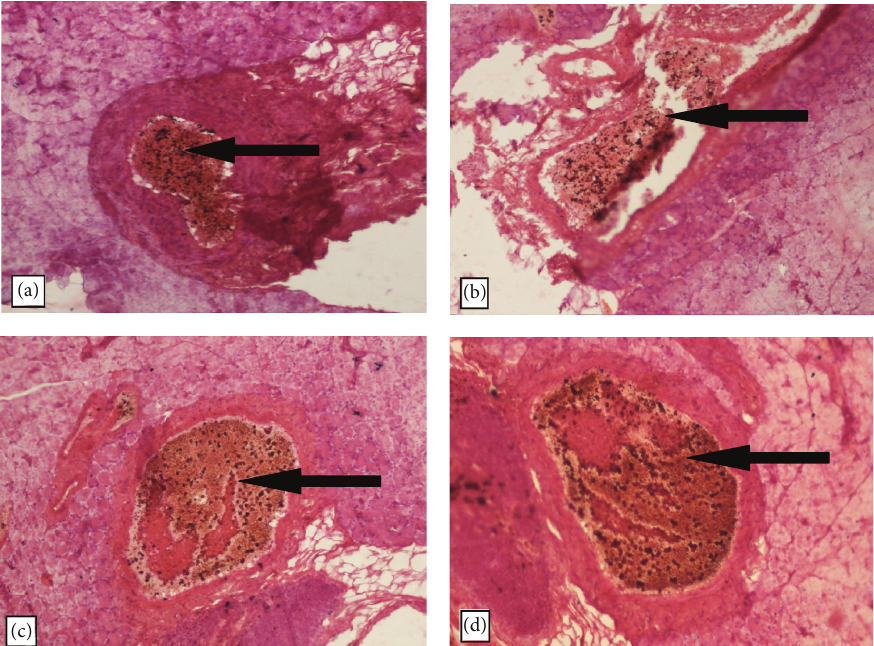
Figure 8: Histopathological view of rat pancreas on treatment with H. cordata at 400 mg/kg; p.o.; arrow indicates the location of 𝛽 -cells of pancreas. (a) Normal control. (b) Diabetic control. (c) Diabetic treated with glibenclamide (10mg/kg; p.o.) and (d) diabetic treated with H. cordata (400 mg/kg;